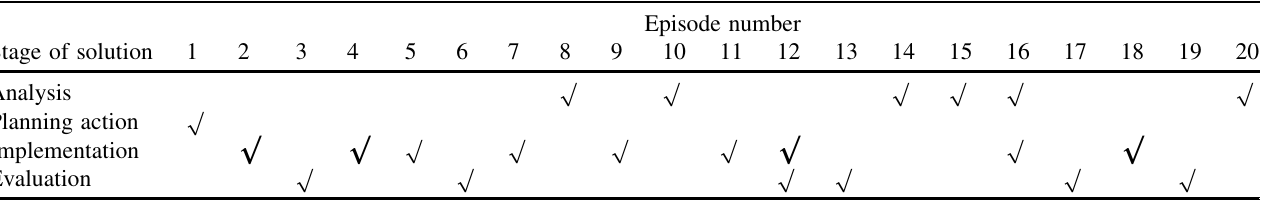
TABLE III. Workshop B (maximal guidance): Episodes mapped to pedagogical problem-solving